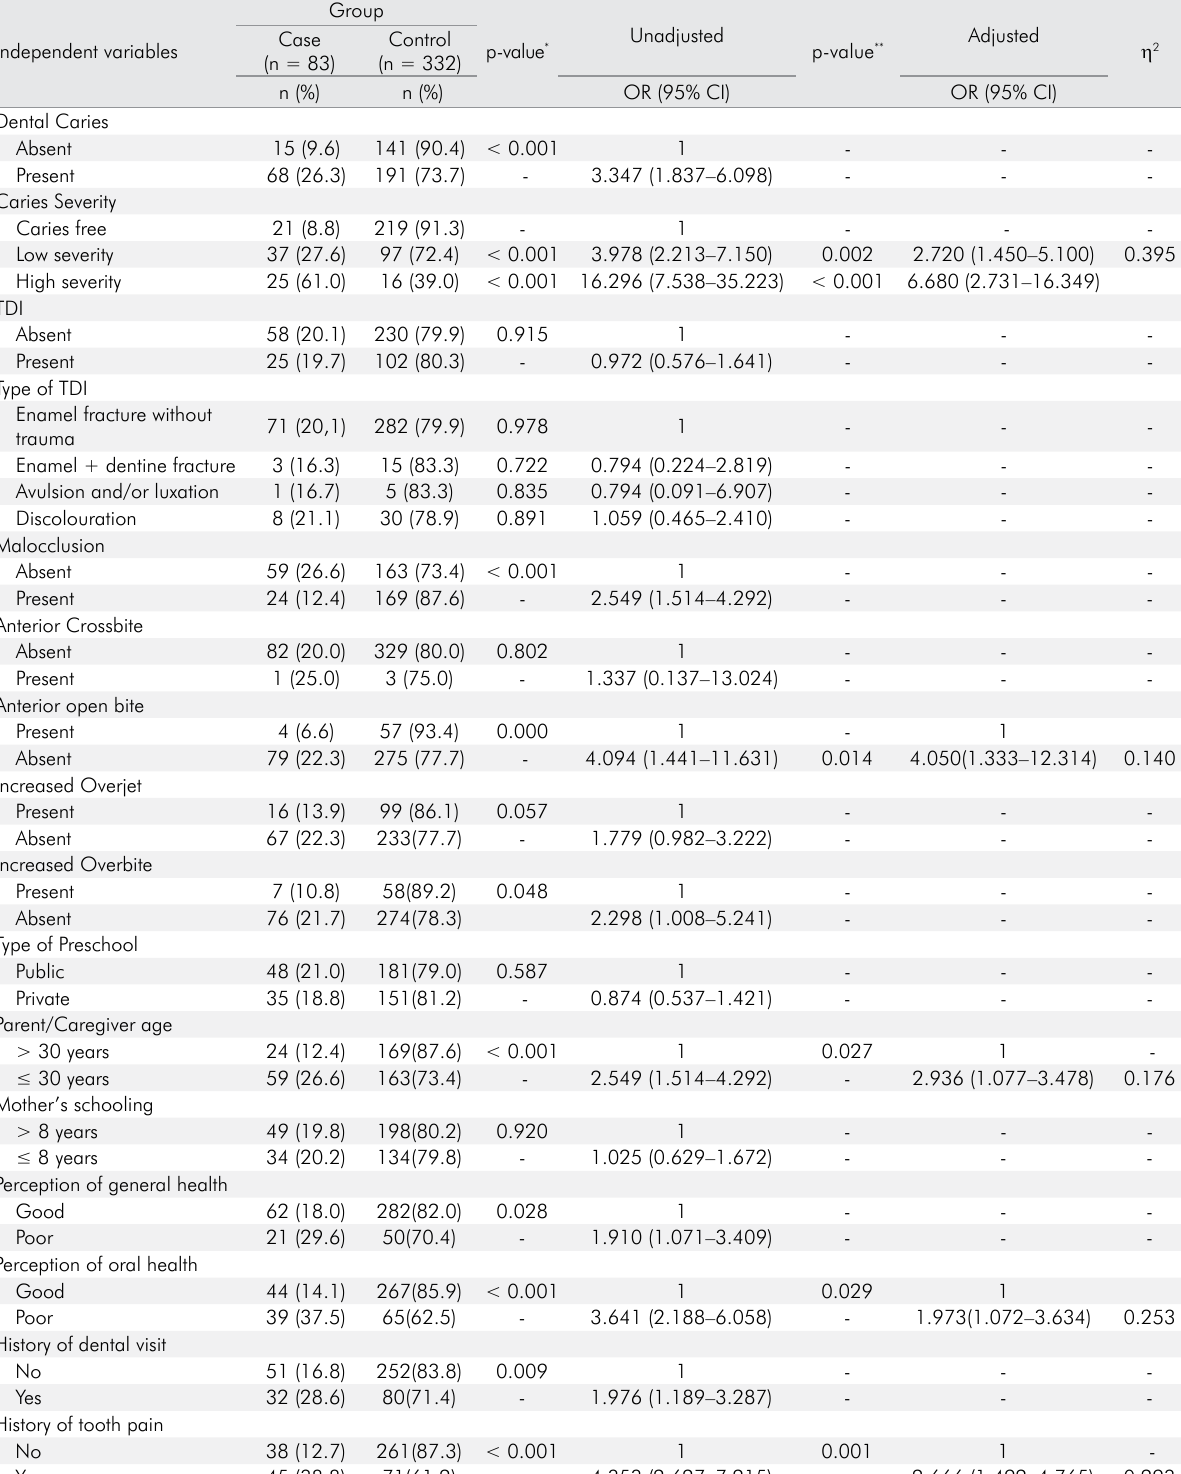
Table 2. Conditional logistic regression analysis and effect sizes of independent variables in study